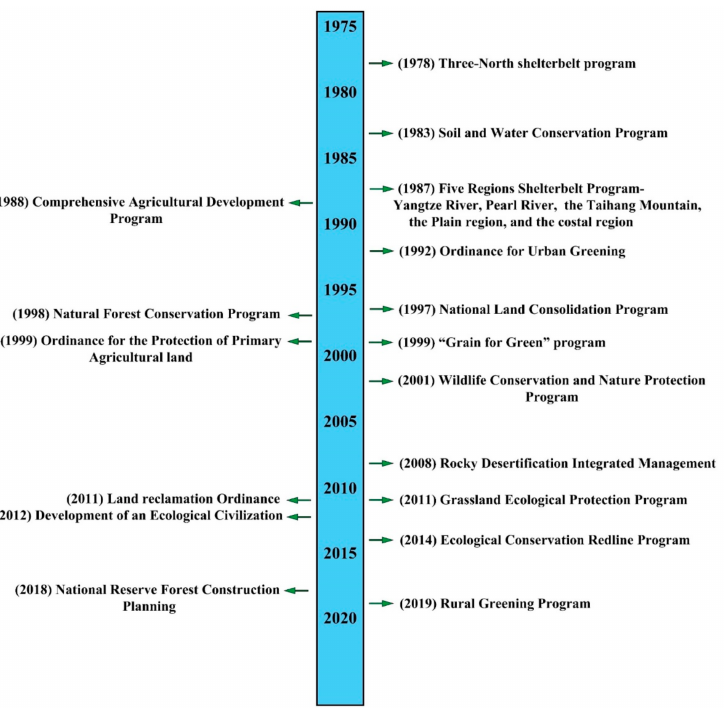
Figure 8. A few of government policies about ecological engineering. (Referred from [59] and https://www.gov.cn/ (accessed on 3 January